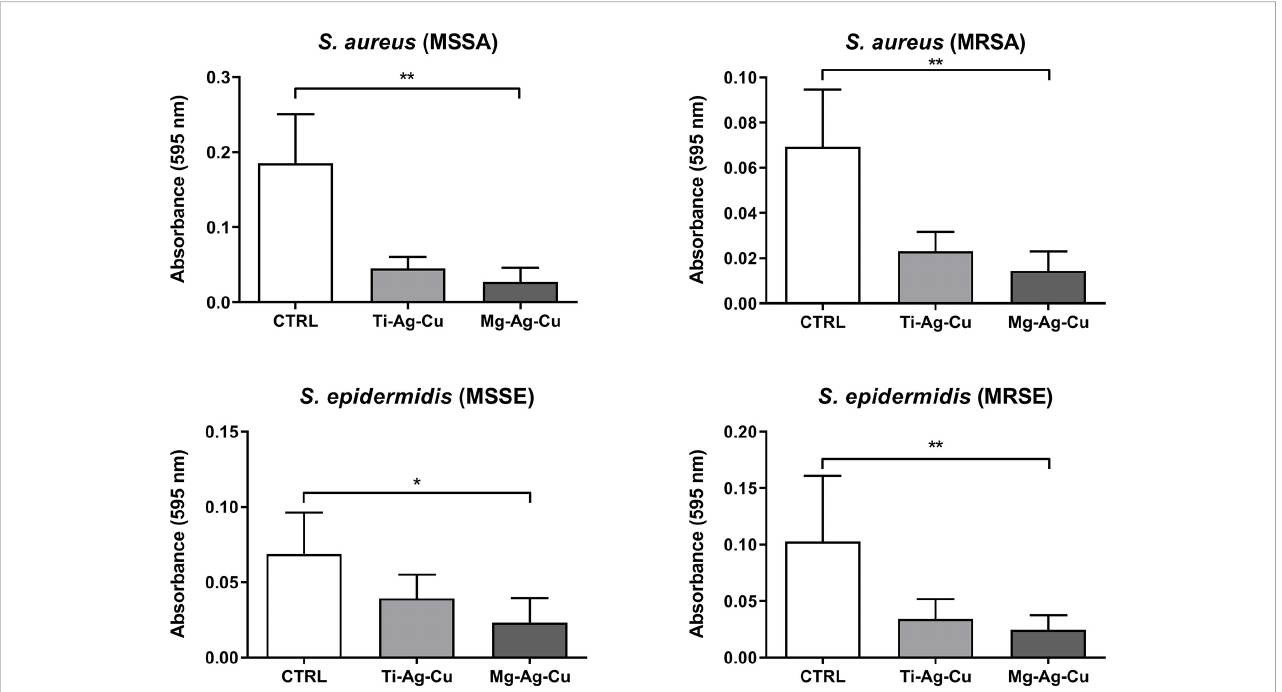
FIGURE 5 Effect of Ti-Ag-Cu and Mg-Ag-Cu coating on S. aureus (MSSA and MRSA) and S. epidermidis (MSSE and MRSE) bio fi lm compared to uncoated glass discs (CTRL) analyzed by means of the spectrophotometric crystal violet assay. Statistical signi fi cance: p < 0.05 (*) and p < 0.01 (**).